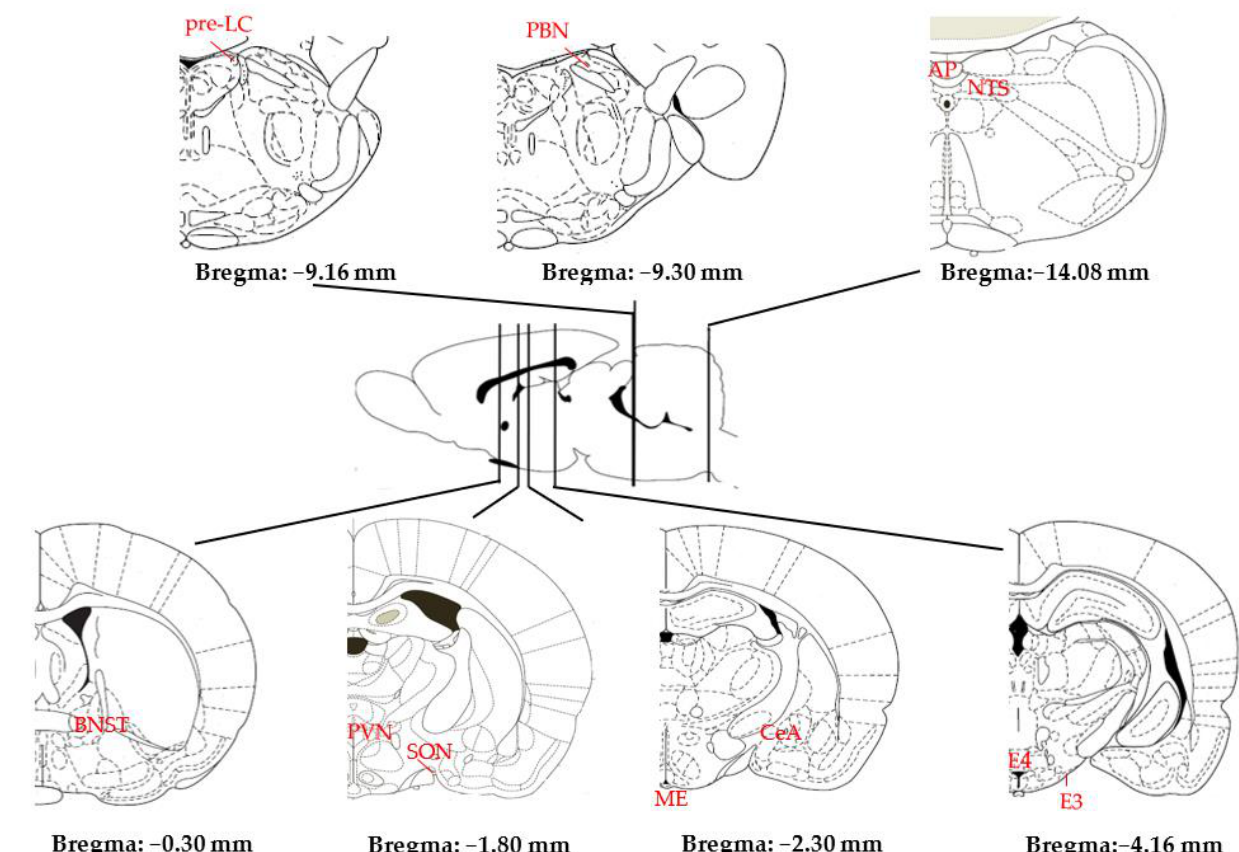
Figure 3. Main structures of the rat brain involved in Na homeostasis (AP: area postrema; BNST: bed nucleus of the stria terminalis; CeA: central amygdala; E3 – E4: medial tuberomammillary nuclei; ME: median eminence; NST: nucleus of the solitary tract; PBN: parabrachial nucleus; pre-LC: pre- locus coeruleus; PVN: paraventricular nucleus; SFO: subfornical organ; SON: supraoptic nucleus) (adapted from [63]).